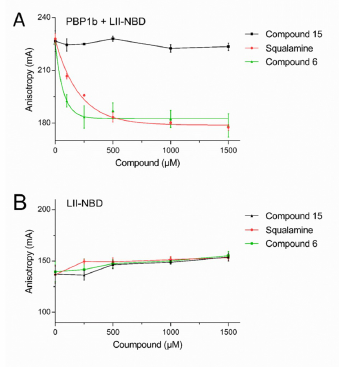
Figure 3. Fluorescence anisotropy assay using the NBD-lipid II as a probe. FA (in mA units) is plotted as a function of compound concentrations. The error bars represent the FA values as mean ± s.d. of triplicate experiments. ( A ) Competition of squalamine and compound 6 for PBP1b/NBD-lipid II binding induce a decrease of the FA of the probe while the inactive compound 15 does not affect the FA. ( B ) Measurements of direct binding between the probe and the compounds show no significant variation of FA, indicating absence of interactions.